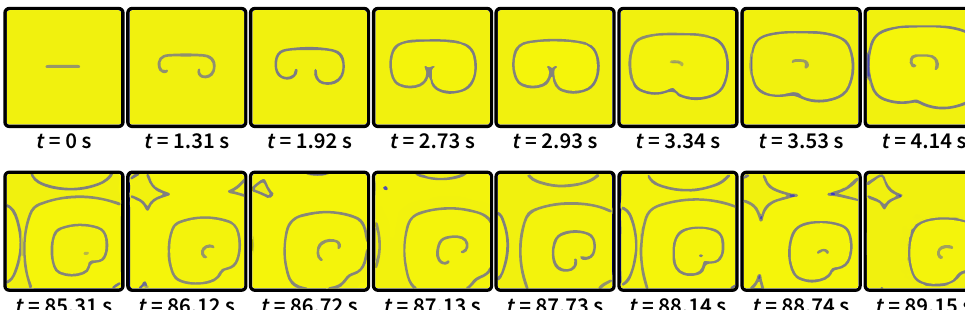
Figure 9. Clockwise and counterclockwise spiral patterns on 2-D media with